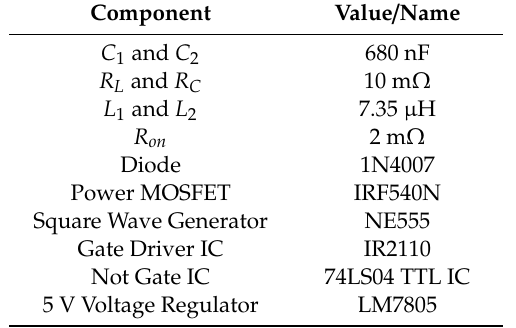
Figure 8. Schematic of the proposed WPT circuit. Table 3. Main components of the proposed wireless power transmission (WPT) H-bridge circuit.